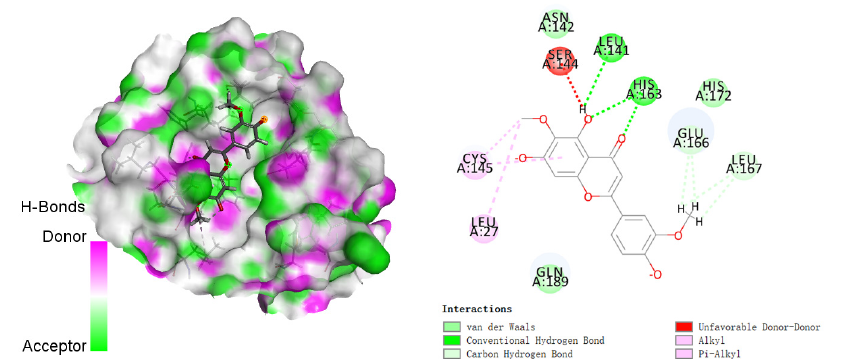
Figure 4. The binding mode of compound 1 (3D view and 2D view) with 2019-nCoV protease. The carbon atoms of compound 1 and 2019-nCoV protease are represented as grey sticks, and oxygen atoms are shown in red. All the nonbonded interactions are shown in dotted lines with different colors according to their different interaction properties.